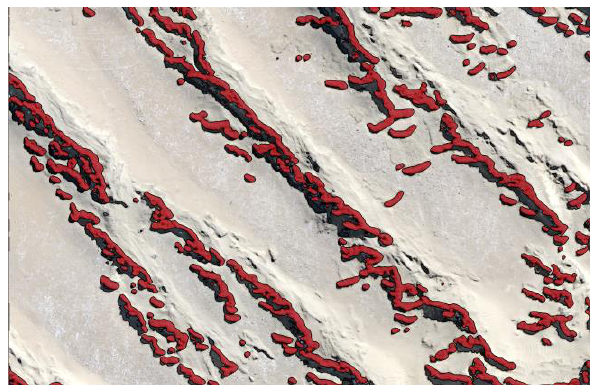
Figure 3. Example of the vegetation cover information extracted using knowledge-based image analysis.